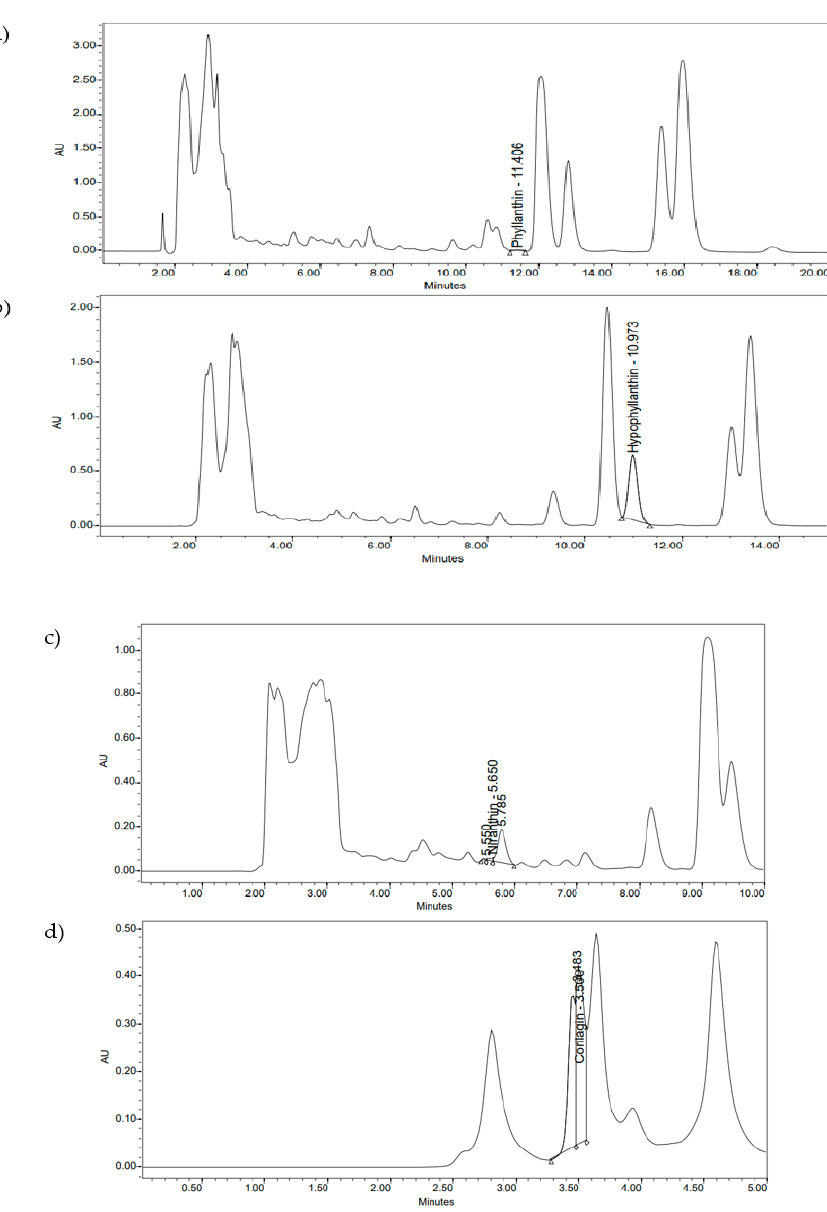
Figure 3. Identification of the compounds in P. amarus extract: ( a ) phyllanthin; ( b ) hypophyllanthin; ( c ) niranthin; ( d ) corilagin using HPLC chromatograms.